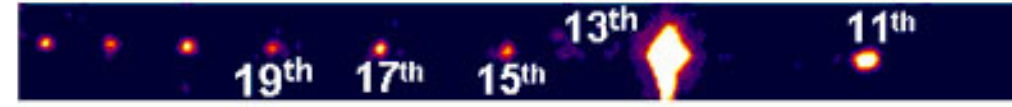
Figure 5. Strong resonance enhancement of a single harmonic is generated from the interaction of a femtosecond pulse with low ionized indium ablation. 4d 10 5s 2 .